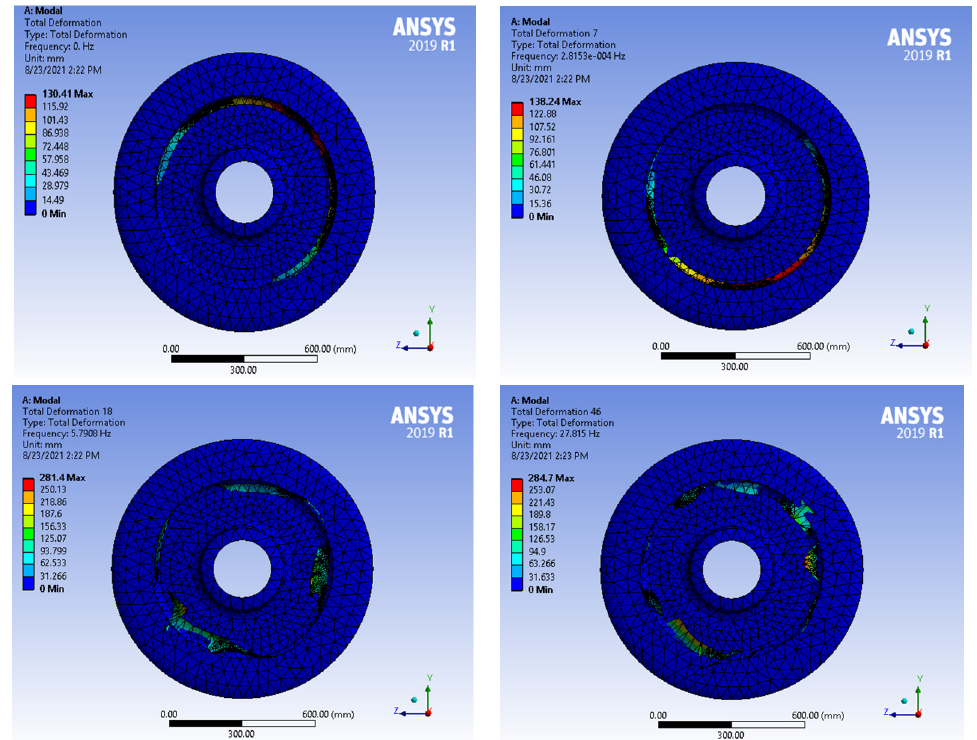
Figure A2. Mode shapes of the wheel mounted with viscoelastic damping layer under the rim of both sides when it starts to experience high amplitudes.